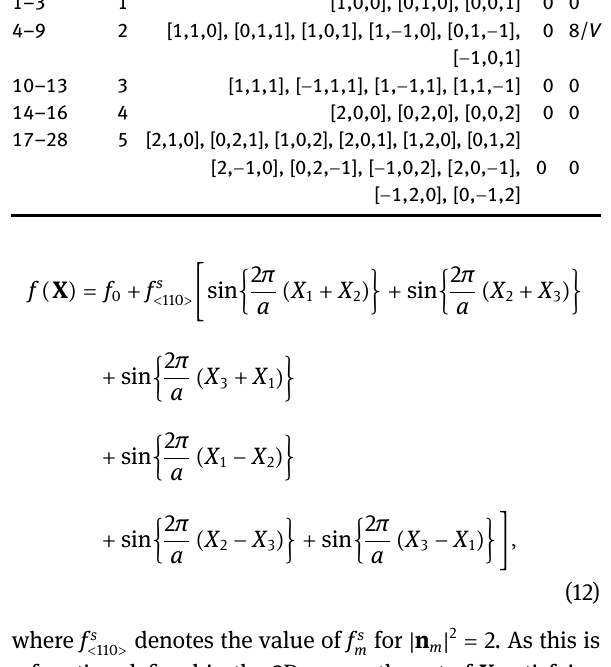
obtained from Eqs. (  ) and (  ).